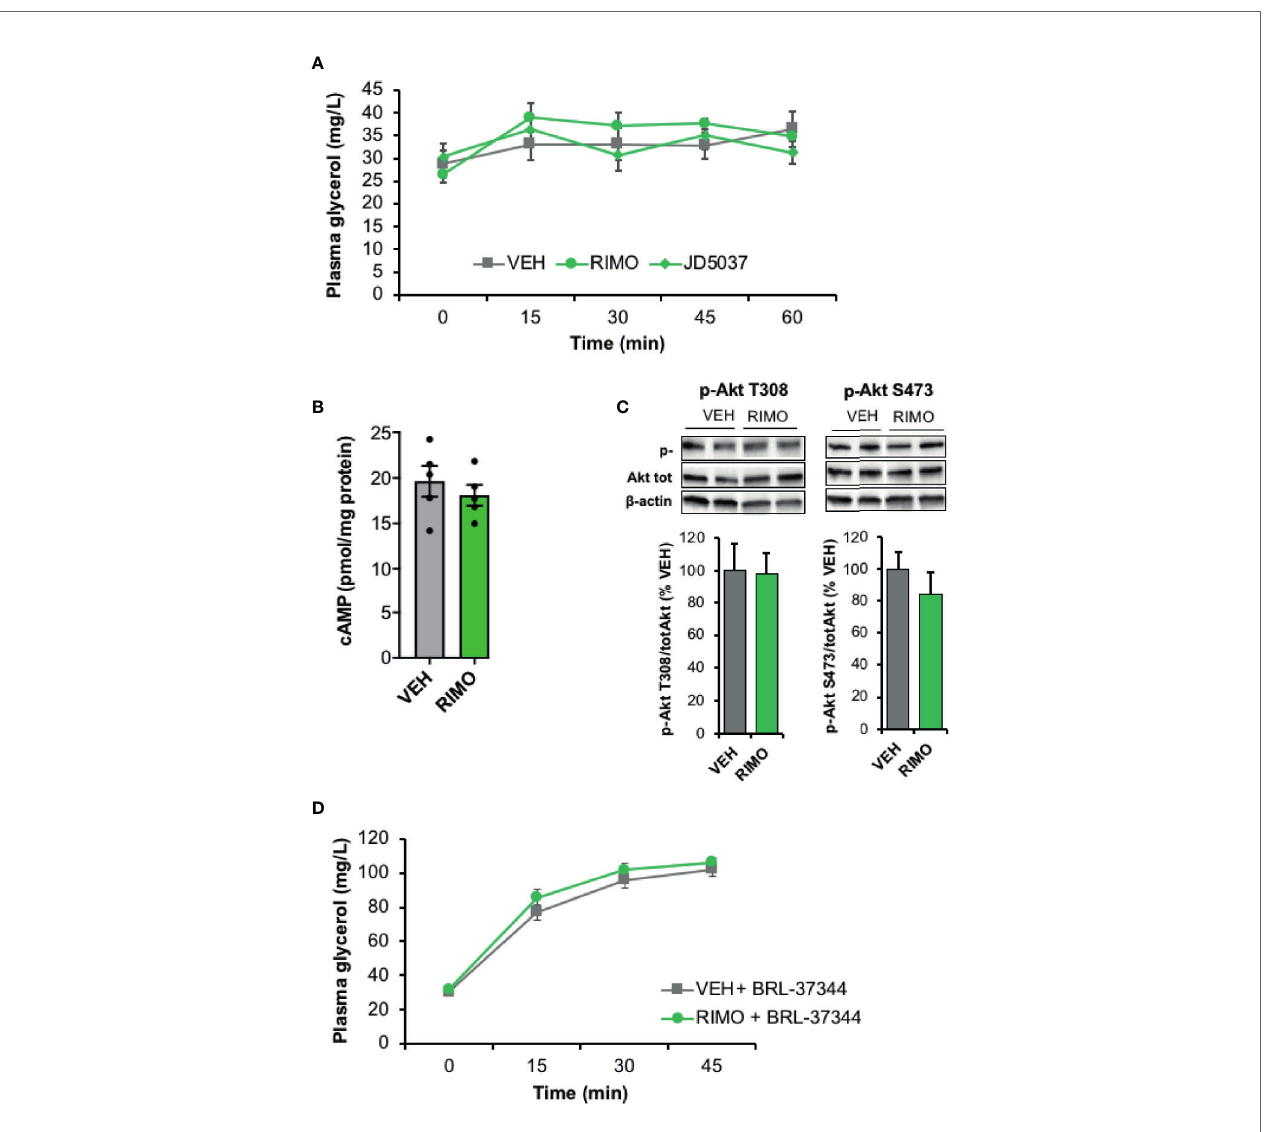
FIGURE 5 | Blockade of WAT CB1R does not modify lipolysis in obese mice in vivo . (A) Kinetic of plasma glycerol (0, 30, 45 and 60 min) in mice fed with a high fat diet (HFD) after a single intraperitoneal injection of vehicle (VEH), Rimonabant (RIMO, 10 mg/kg) or JD5037 (3 mg/kg); n=9/group. (B) Intracellular cAMP content in WAT collected from HFD mice 45 min after an intraperitoneal injection of VEH or RIMO (10 mg/kg); n=4/group. (C) Representative immunoblots and densitometry analyses of the phosphorylation level of Akt (T308, S473) in WAT collected from HFD mice 15 min after an intraperitoneal injection of VEH or RIMO (10 mg/kg); n=5/ group. (D) Kinetic of plasma glycerol (0, 30, and 45 min) in HFD mice after an intraperitoneal injection of BRL-37344 (5 mg/kg) in the presence of vehicle (VEH) or Rimonabant (RIMO, 10 mg/kg); n=4/group. Results are expressed as mean ±